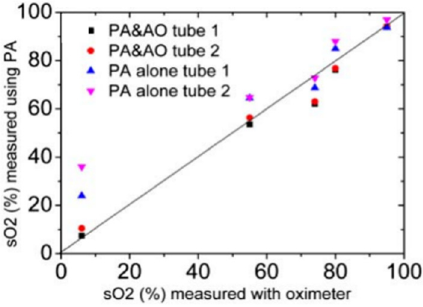
Figure 5. Comparison of the estimated sO 2 using PA alone and AO-assisted fluence-compensated PA versus sO 2 measured with an oximeter; the solid line represents the exact estimation. Reprinted from [67] .